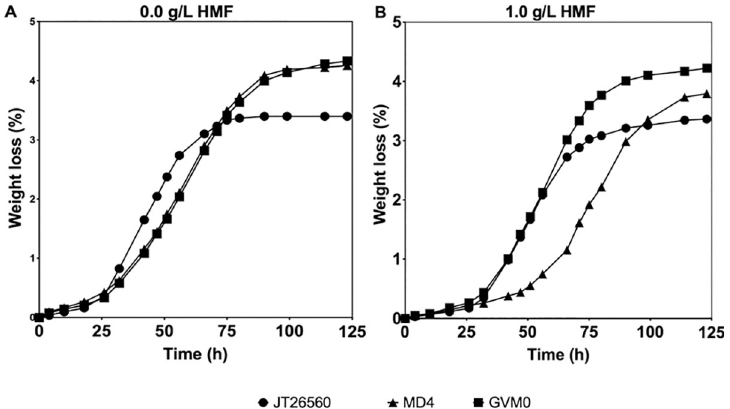
Fig 2. Fermentation performance of WG transformant GVM0 in HMF-enriched corn cob hydrolysate. Small-scale fermentations (10 mL) were performed in corn cob hydrolysate enriched with 0.0 g/L or 1.0 g/L HMF, pH 5.2, 35˚C, 350 rpm and initial OD 5.0. (JT2650, C . glabrata ; GVM0, WGT of MD4). Representative result of two biological replicates is